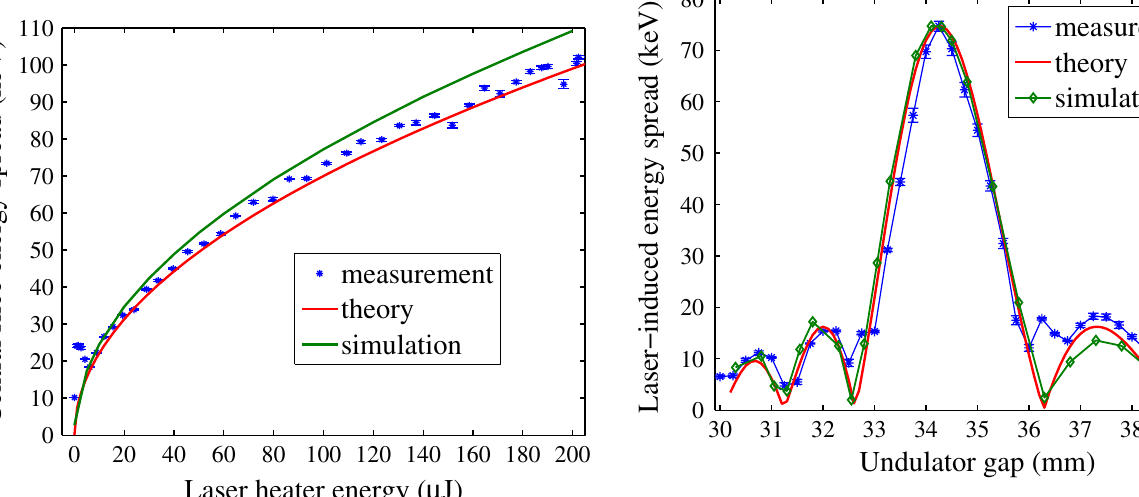
FIG. 9. (Color) Laser-induced rms slice energy spread vs LH- undulator gap (LH energy is about 200 (cid:1) J